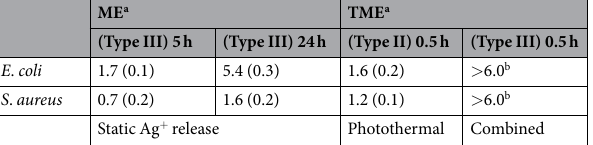
Table 2. Microbicidal effect on planktonic bacteria for non-irradiated surfaces (ME) and after laser irradiation (TME). a Values are the average of three measurements. Standard deviations between brackets. b A value higher than 6 indicates that no survived bacteria were found after the